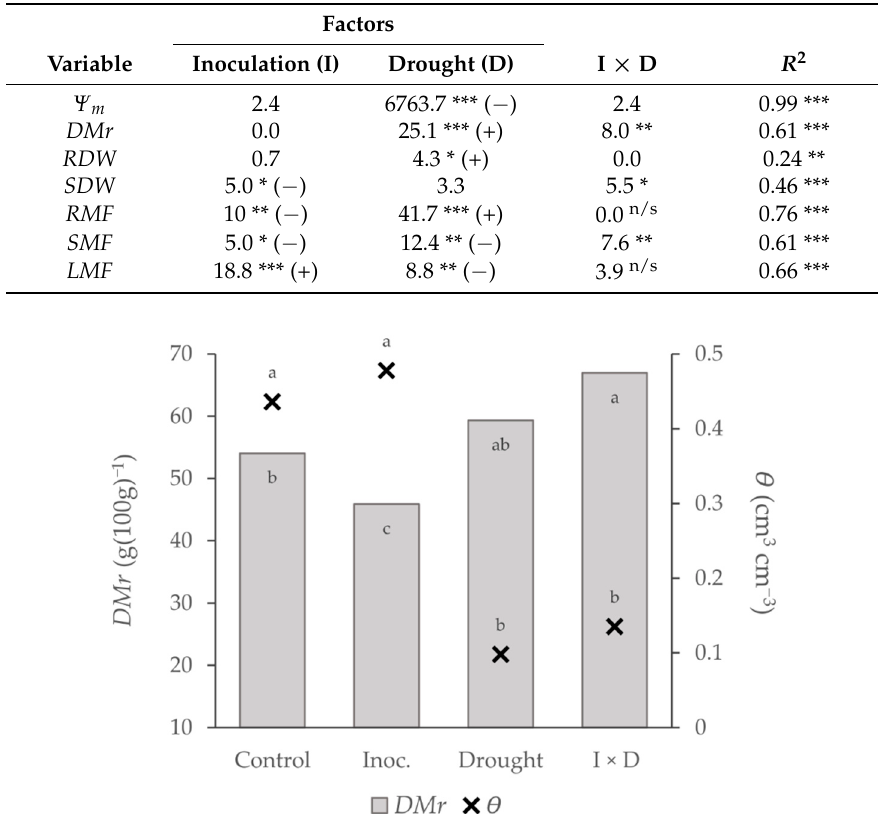
Table 3. Two-way ANOVA results for variables measured 30 dpi. Values of F statistic are highlighted in bold type when significant (* p < 0.05; ** p < 0.01; *** p < 0.001; n/s, not significant). R 2 represents corrected ANOVA model adjustment. (+) or ( − ) mean that the factor has a positive or negative effect, respectively.